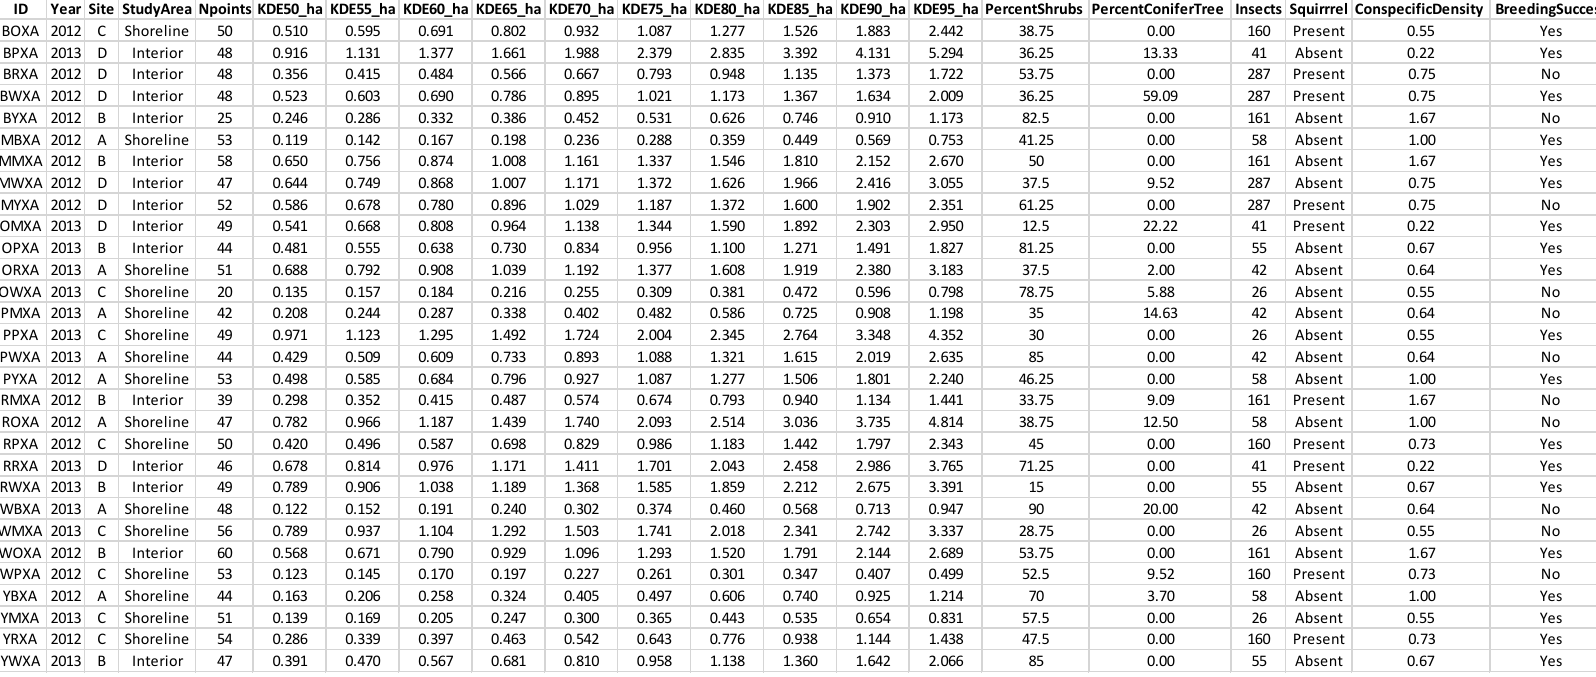
Table A1.1. Data set used in the paper of the territory attributes of Canada warblers at Slave Lake, Alberta,